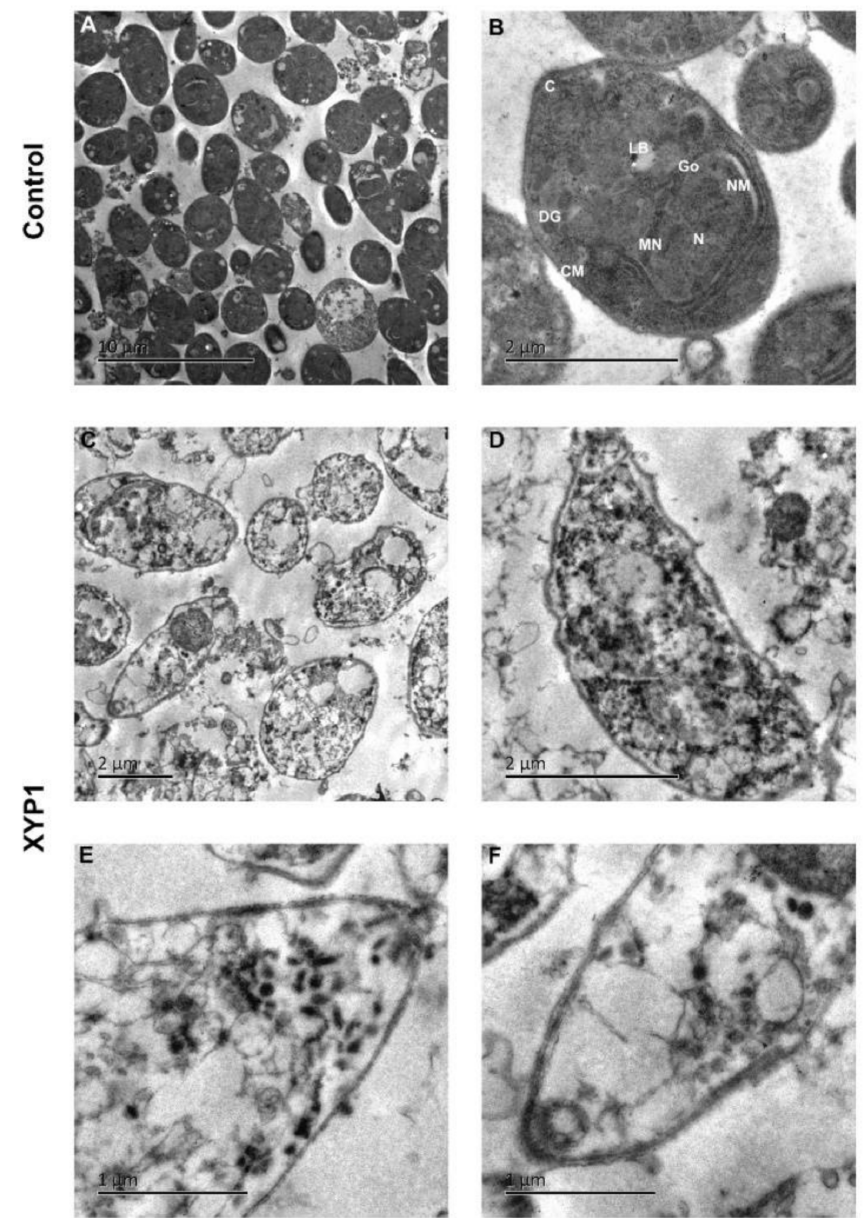
Figure 6. Ultrastructural effects of XYP1 on T. gondii tachyzoites as visualized by TEM. Parasites treated with DMEM were defined as the negative control ( A , B ). Tachyzoites were exposed to 10 µ M XYP1 for 2 h ( C – F ). Abbreviations in B: C, conoid; CM, cell membrane; DG, dense granule; Go, golgi complex; LB, lipid body; MN, microneme; N, nucleus; NM, nuclear membrane. Scale bars = 10 µ m ( A ); 2 µ m ( B – D ); 1 µ m ( E , F